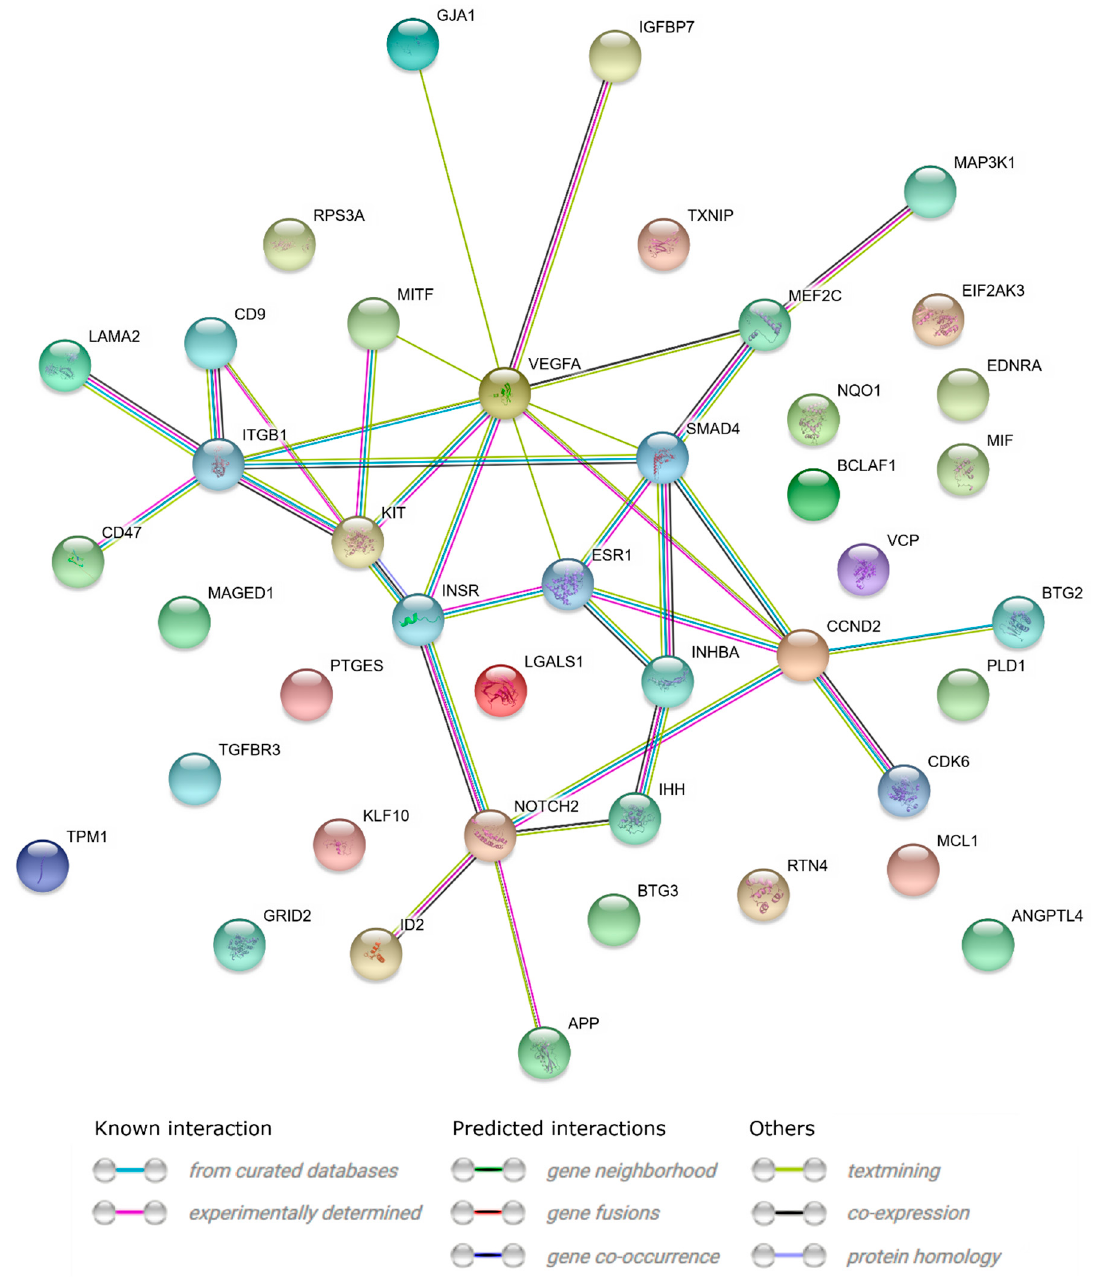
Figure 5. STRING-generated interaction network between genes that belongs to the “cell proliferation”, “regulation of programmed cell death”, and “regulation of cell migration”. The intensity of the edges reflects the strength of the interaction score.